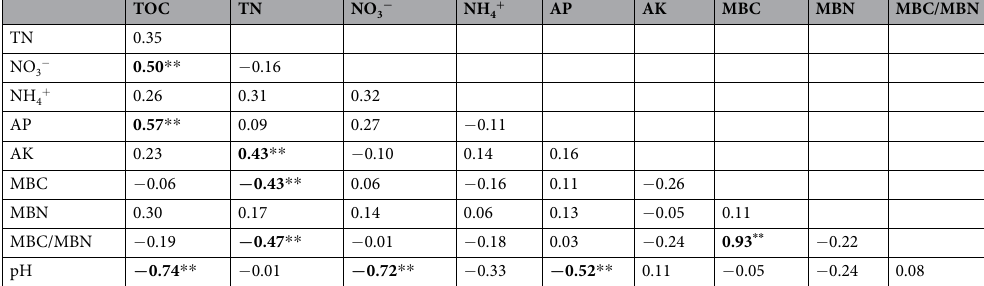
Table 3. Results of Pearson correlation analysis of soil nutrient availability, microbial properties and pH in a secondary evergreen broad-leaved forest ecosystem ( n = 27). * Correlation is significant at the 0.05 level